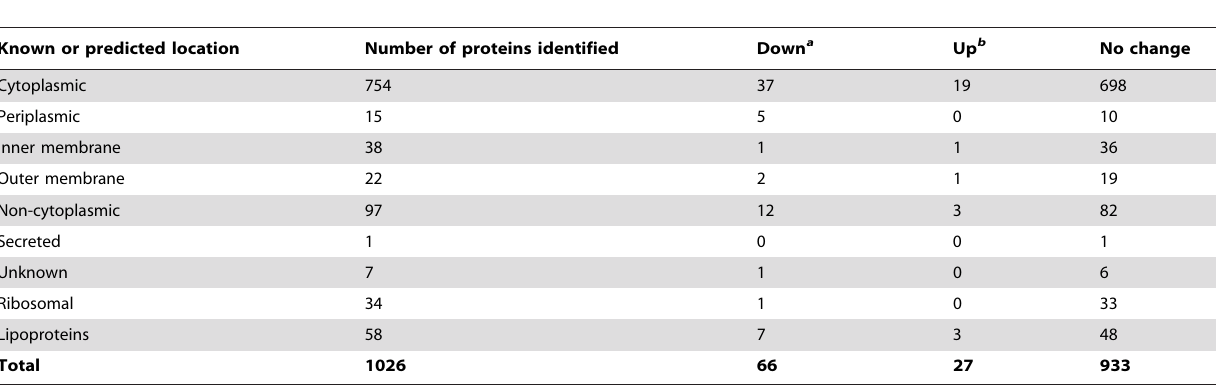
Table 1. Number of leptospiral proteins identified in the 37 u C vs 30 u C samples per predicted location. The number of differentially expressed proteins in each location is shown.